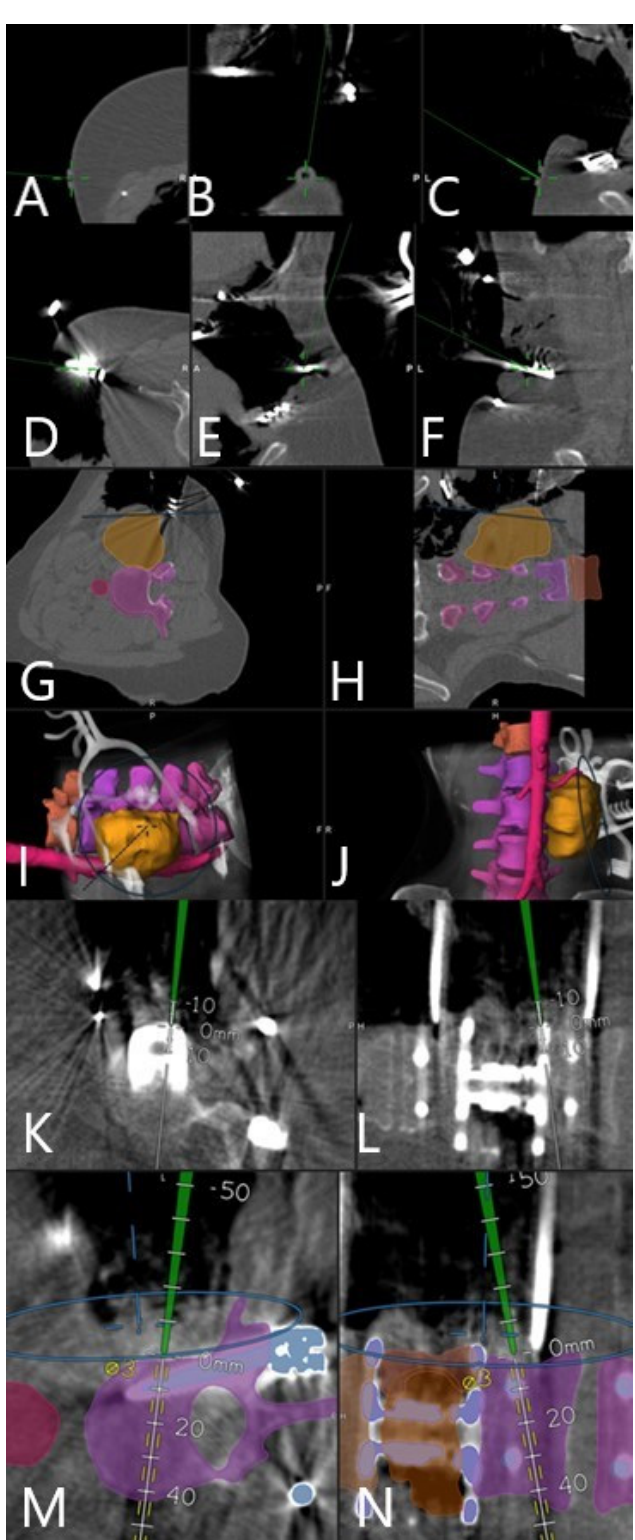
Figure 1. Navigation accuracy check using tip of the navigation pointer. ( A – C ) In the divot of a skin fiducial (patient no. 10). ( D – F ) On the spine retractor (patient no. 10). ( G – J ) On the outer tumor surface (patient no. 10). ( K , L ) On the expandable vertebral body cage (patient no. 11). ( M , N ) On the lateral surface of the vertebra (patient no. 11).